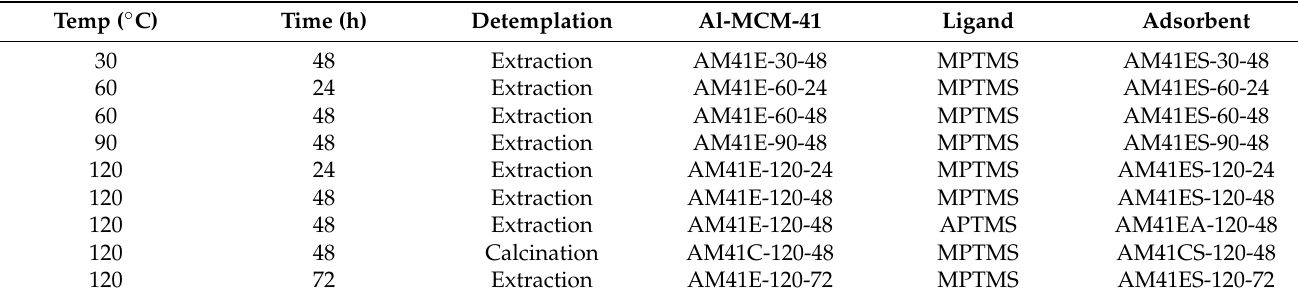
Table 12. Nomenclature of samples synthesized at different crystallization